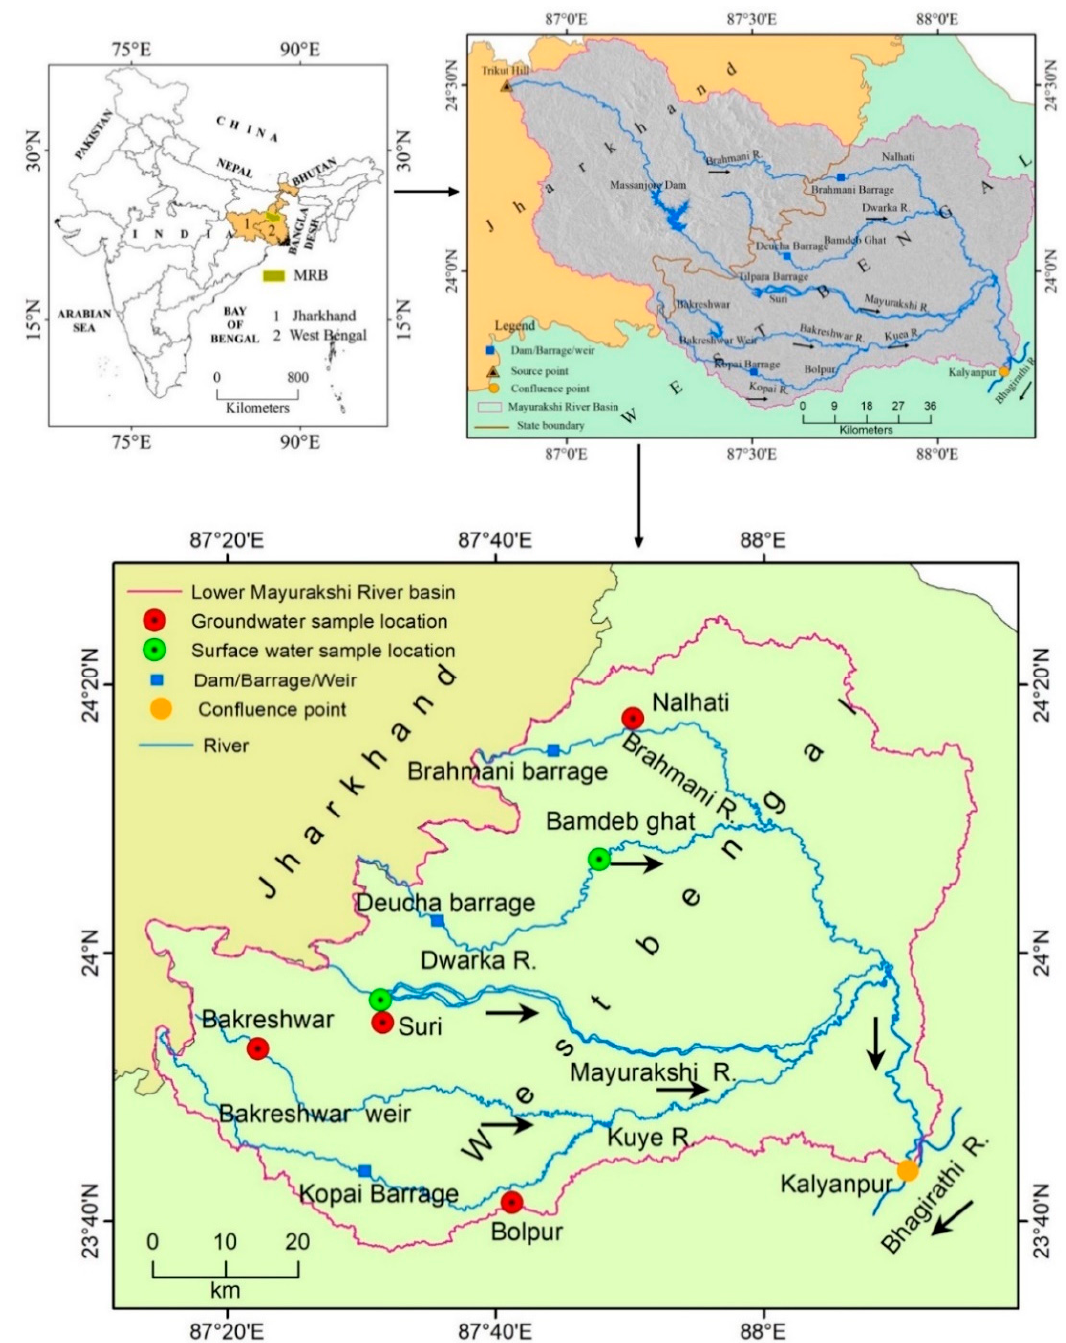
Figure 1. Location of the study area.